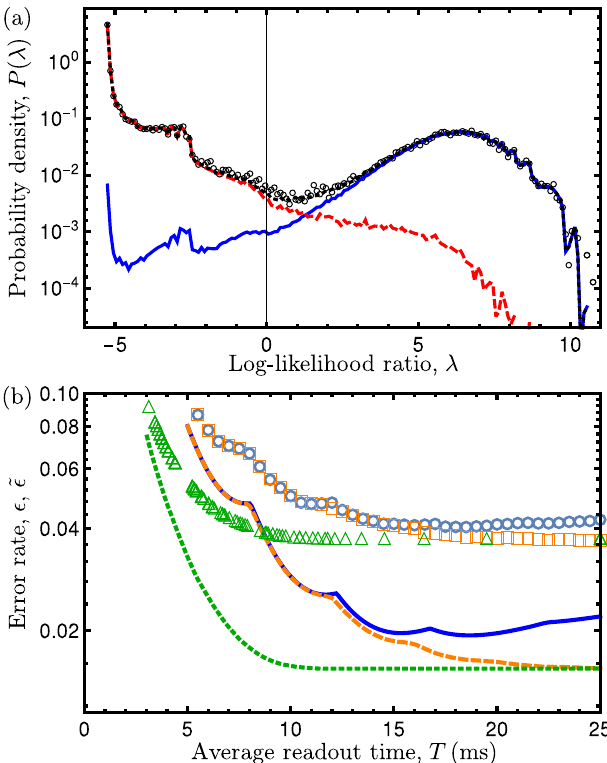
FIG. 11. (a) Experimentally measured probability density P ð λ Þ of the log-likelihood ratio λ (black circles) for subtrajectories of λ Þ (dotted black) duration 25 ms. The theoretical prediction P theo ð and the corresponding weighted conditional distributions λ jþÞ P λ j − Þ P − Þ (dashed P (solid blue) and P theo ð theo ðþÞ theo ð theo ð red) are shown for comparison. The theoretical prior probabilities P are taken to be the stationary values corresponding to theo ð(cid:3)Þ the extracted rates, Eq. (E6). (b) Experimental error rate ~ ϵ of the photon-counting method (blue circles), the nonadaptive MLE (orange squares), and the adaptive MLE (green triangles). The theoretical error rate ϵ of Fig. 5 is reproduced for comparison (solid blue for the photon-counting method, dashed orange for the nonadaptive MLE, and dotted green for the adaptive MLE). The discrepancy between experiment and theory can be attributed to preparation errors [see Eq.